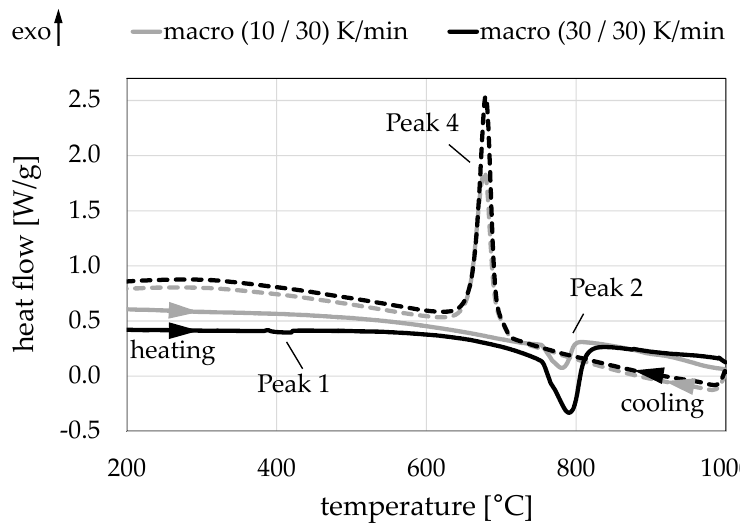
Figure 7. Example of heat flow curves of DSC measurements of macro samples for a heating rate of 10 K/min and 30 K/min and a cooling rate of 30 K/min.